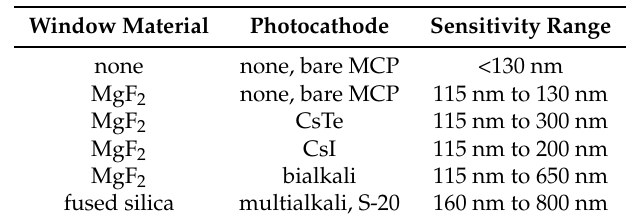
Figure 2. Transmission of three common window materials as a function of the photon wavelength as declared by the supplier. Blue solid line: MgF 2 [5], blue dash-dotted line: MgF 2 [6], black dotted line: fused silica (”suprasil”) [5], red dashed line: N-BK7 [7]. Table 1. Common combinations of window and photocathode materials and their sensitivity range. The expression ”bialkali” usually refers to Sb-Rb-Cs or Sb-K-Cs materials and ”multialkali” (also ”S-20”) to Na-K-Sb-Cs